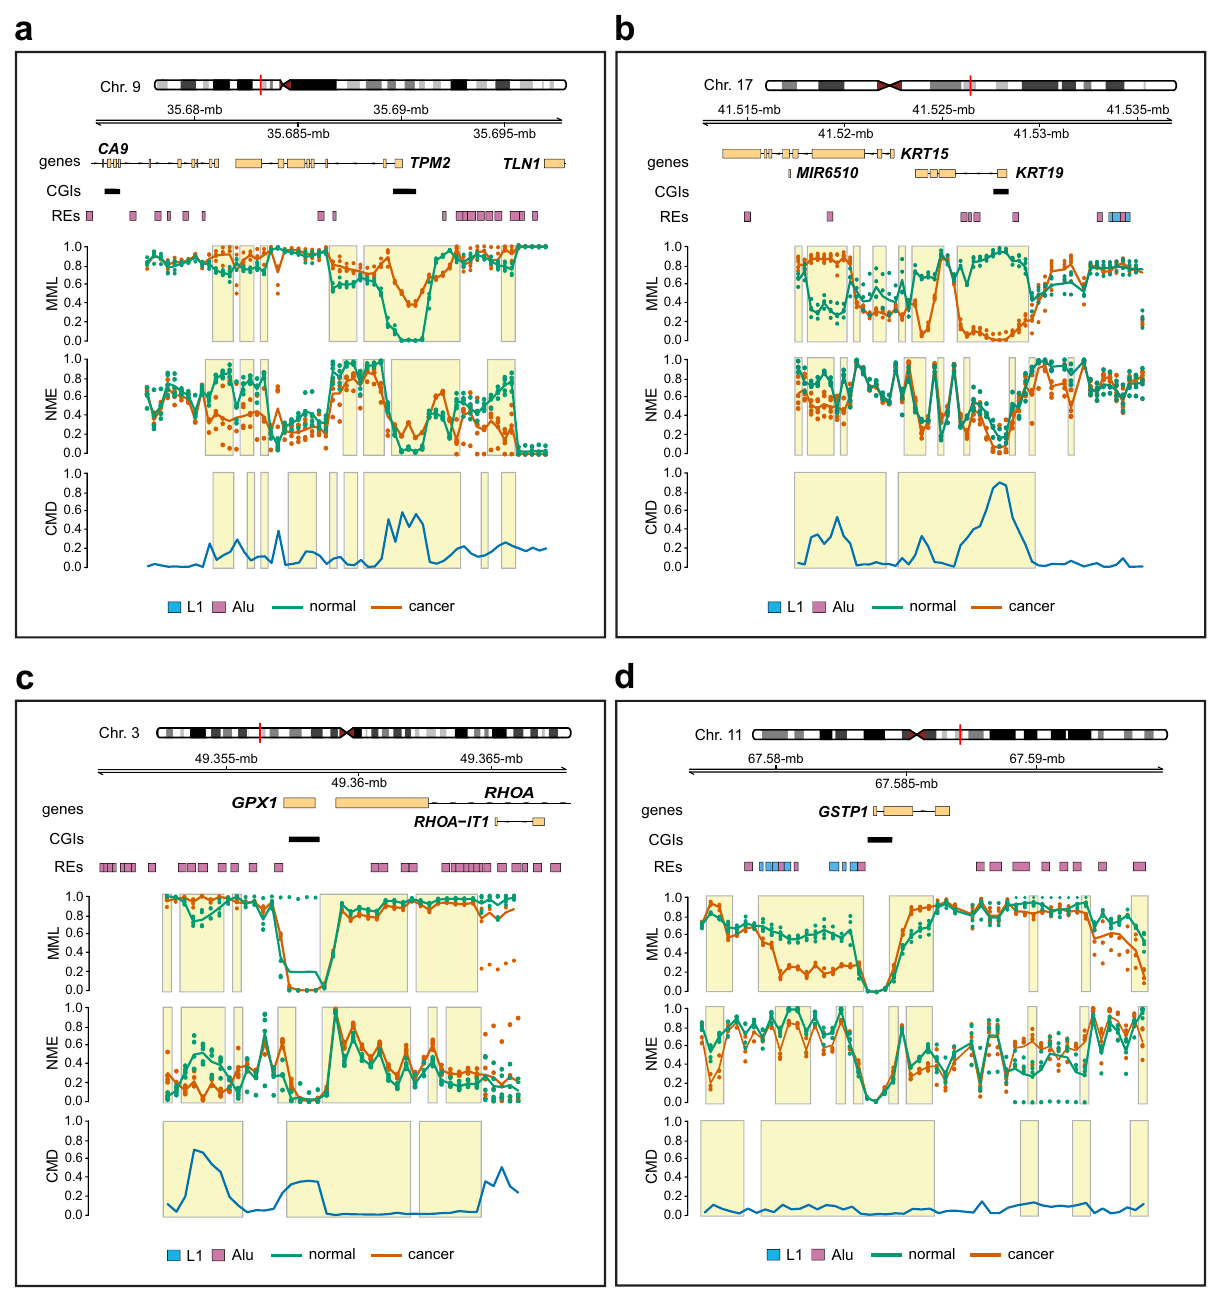
Figure 5. Methylation discordance, genes, and repetitive elements in the targeted breast normal/cancer comparison. ( a ) Averages of mean methylation levels (MMLs) and normalized methylation entropies (NMEs), observed in two groups of five “normal” (green lines) and five “cancer” (red lines) samples used for differential analysis, over genomic regions overlapping TPM2 and CA9 . The average of all differences in the probability distributions of methylation between the two groups, quantified by the coefficient of methylation divergence (CMD), is also depicted (blue line). Dots indicate individual MML and NME values for each group and sample, whereas boxes delineate genomic regions of significant ( q ≤ 0.05 ) DNA methylation discordance. CGIs track: CpG islands; REs track: L1 (blue) and Alu (purple) repetitive elements. ( b ) Results of methylation discordance associated with KRT19 and KRT15 . ( c ) Results of methylation discordance associated with GPX1 and RHOA . ( d ) Results of methylation discordance associated with GSTP1